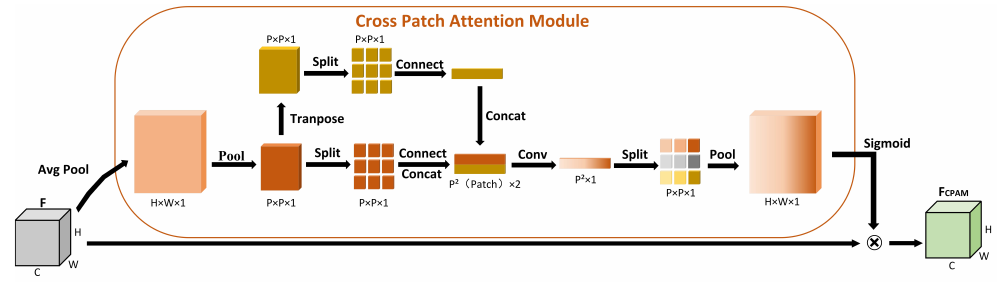
Figure 1. The structure of CPAM.